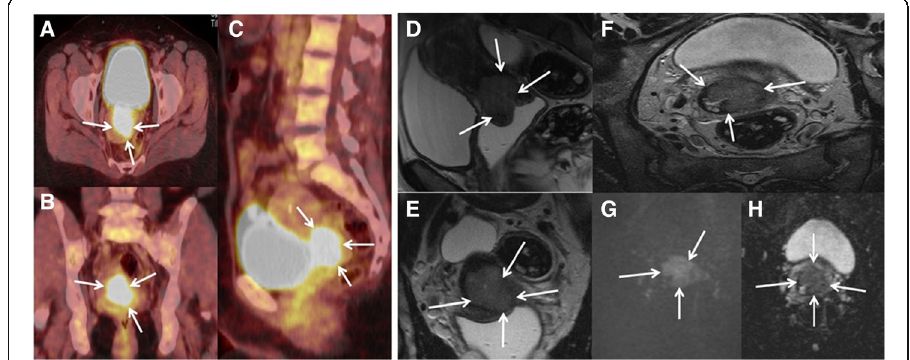
Fig. 2 A 47-year- old woman with FIGO stage IIB cervical cancer with FDG avid cervical tumour encircled (arrows in a , b and c ) yielding a MTV of 20, TLG of 170 and SUVmax of 16. The T2-weighted MR images show a cervical tumour (arrows in d , e and f ) and corresponding diffusion-restriction in b800 DWI ( g ) and ADC map ( h ). This patient was alive with no signs of cervical cancer at follow-up date nine months after primary treatment. ( a : Axial PET/CT, b : Coronal PET/CT, c : Sagittal PET/CT, d : Sagittal T2-weighted MRI, e : Coronal T2-weighted MRI and f : Axial T2-weighted